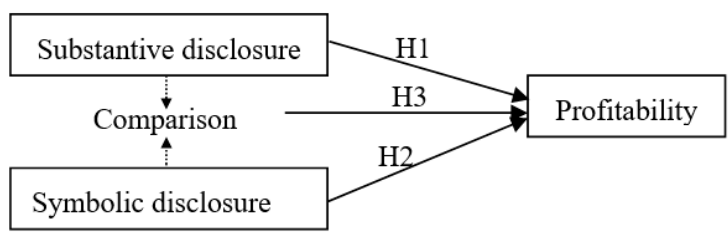
Figure 1. Research framework.